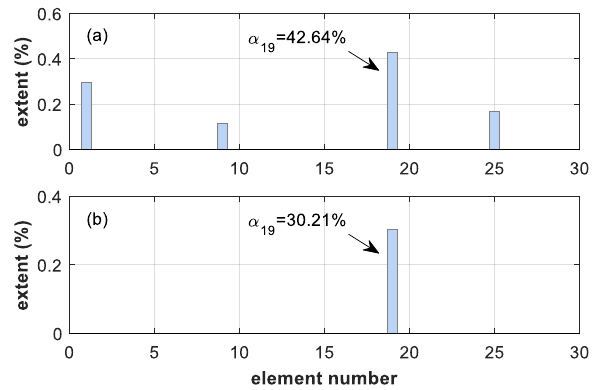
Figure 8. Damage identification results of damage case B at a 3% level of noise, with an iterative Tikhonov solution: ( a ) CMSE method; ( b ) RCMSE method.